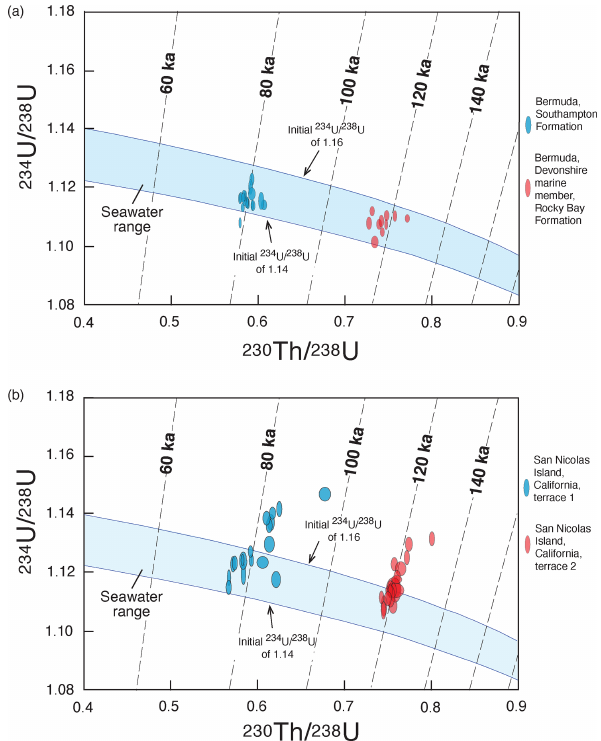
Figure 9. Isotopic evolution diagrams for (a) colonial corals from the Southampton Formation ( ∼ 80ka) and Devonshire marine member of the Rocky Bay Formation ( ∼ 120ka) of Bermuda and (b) solitary corals from terrace 1 ( ∼ 80ka) and terrace 2 ( ∼ 120ka) of San Nicolas Island, California. Bermuda data are from Muhs et al. (2002b) but do not include two samples that have evidence of U loss. San Nicolas Island data are from Muhs et al. (2006). Blue bands show isotopic evolution pathways for corals having mostly closed-system history and initial 234 U / 238 U activity values of 1.16 to 1.14, which bracket measured values in modern seawater (Chen et al., 1986; Delanghe et al., 2002) and modern corals (Muhs et al.,